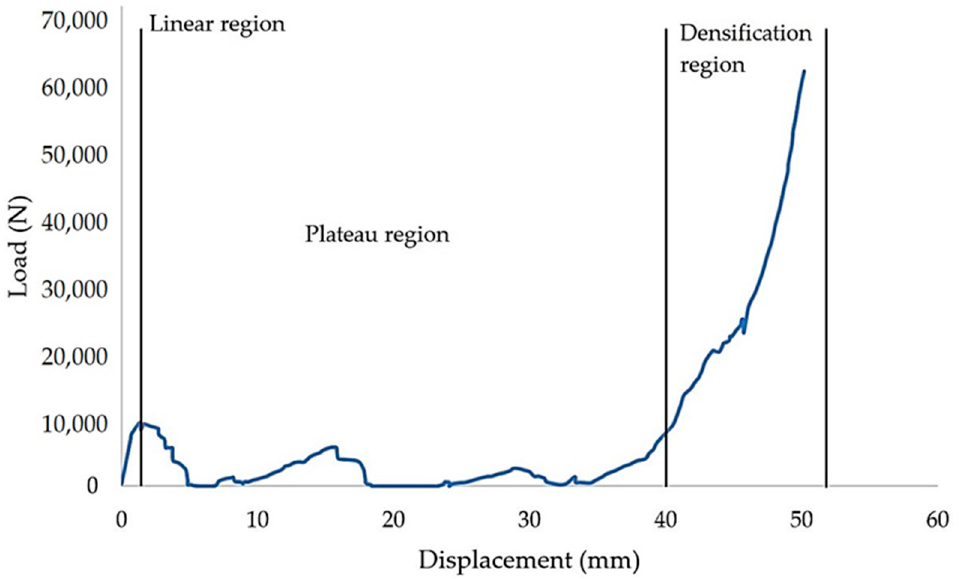
Figure 9. Cell size 20 mm, wall thickness 2.5 mm load-displacement mean curve.